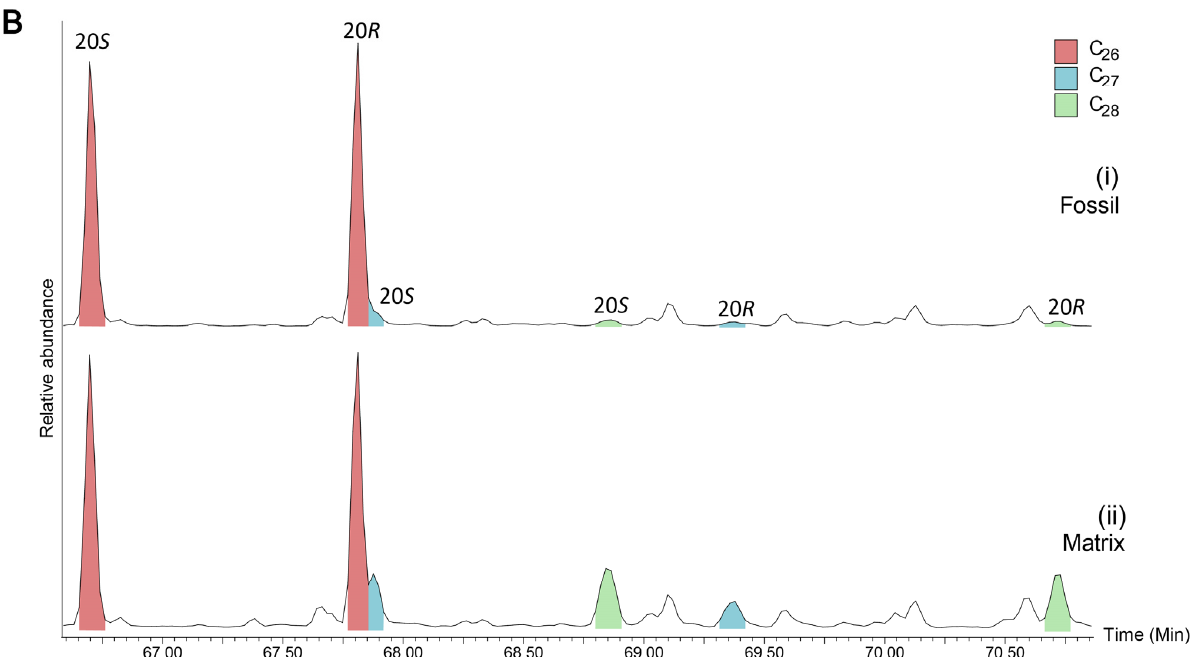
Figure 3. ( A ) Selected Ion Recording (SIR) m / z = 253 chromatogram of C 27–29 monoaromatic steroids of PE 52336 Fossil ( i ) and Matrix ( ii ). I = 5 β (H),10 β (CH 3 ); II = 5 α (H),10 β (CH 3 ); V = 5 β (CH 3 ),10 β (H); VII = 5 α (CH 3 ),10 α (H). Percentages represent the relative abundance of the most abundant peak in each transition. ( B ) SIM m / z = 231 chromatogram of C 26–28 triaromatic steroids of PE 52336 Fossil ( i ) and Matrix ( ii ). S / R refers to the stereochemistry at C-20.